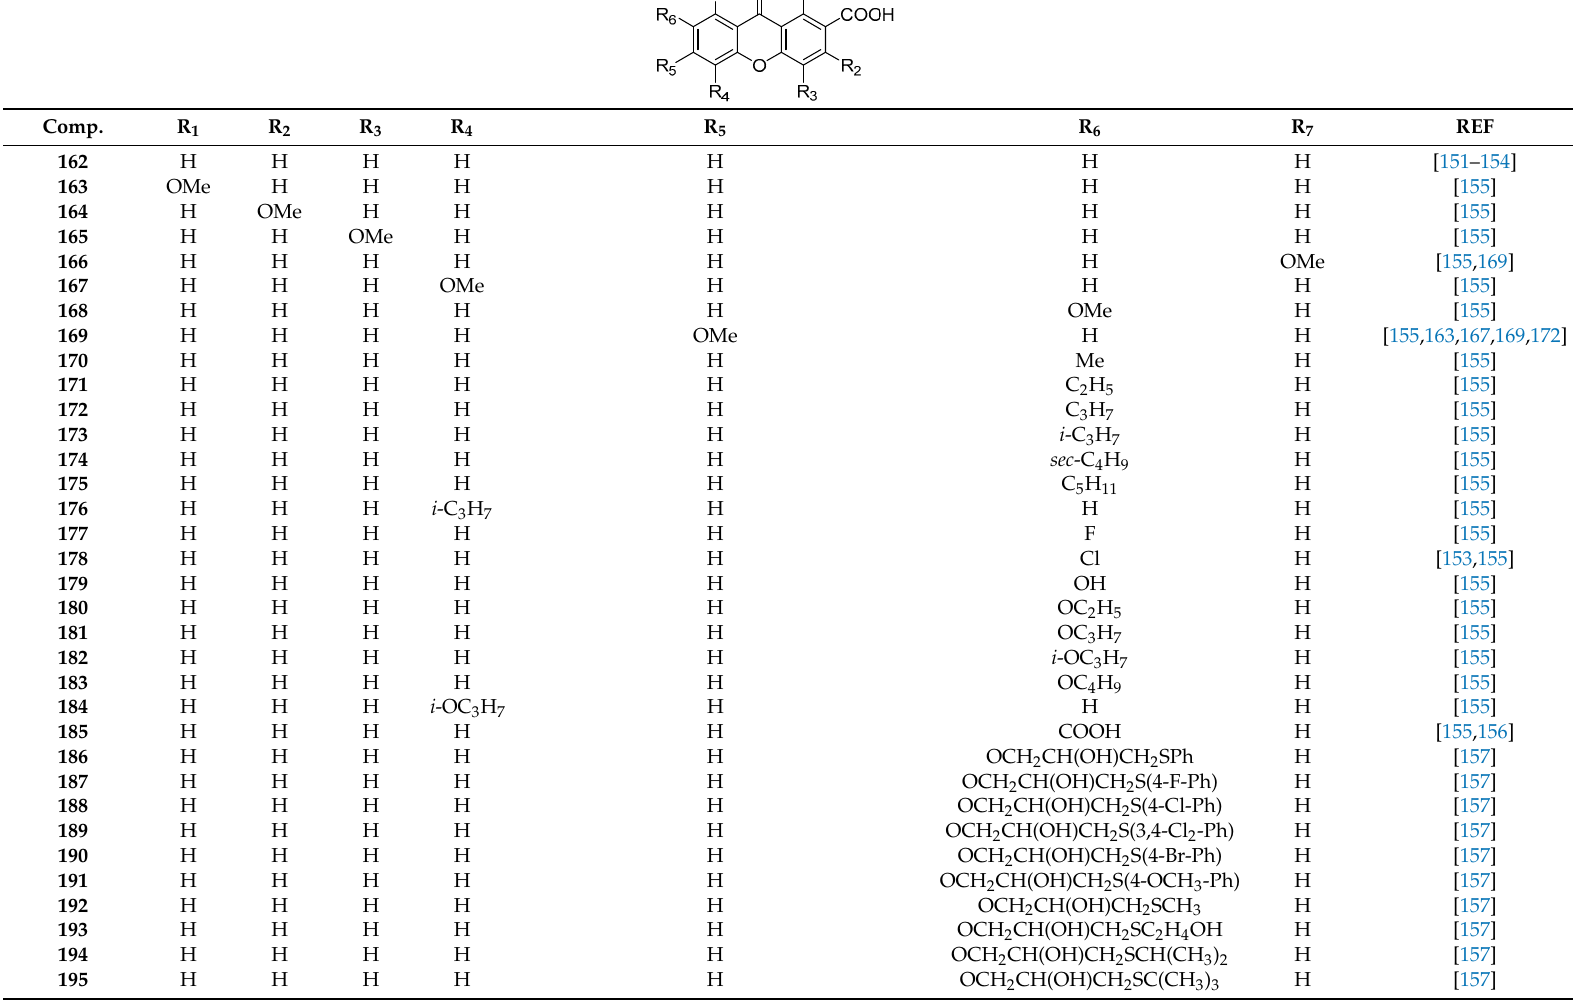
Table 1. Structure of 9-oxo-9 H -xanthene-2-carboxylic acid ( 162 ) and analogues ( 163 – 284 ).